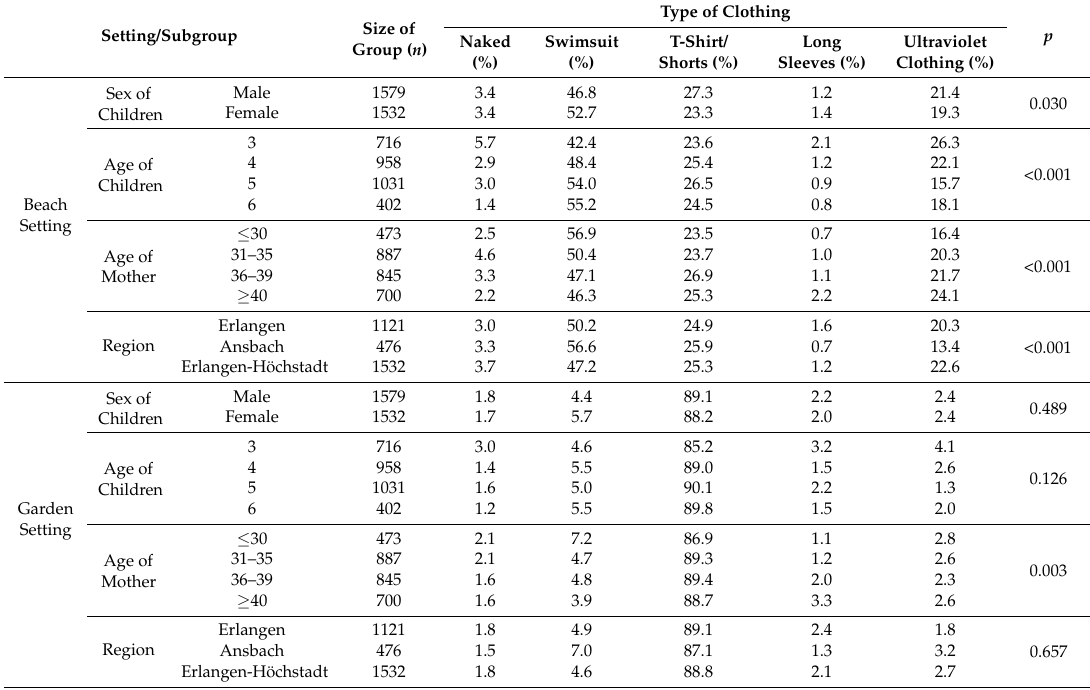
Table 1. Types of clothes worn in two outdoor settings (beach—upper part and garden—lower part) based on answers of 3129 parents of three- to six-year old children in the Erlking-II-study in three Bavarian districts in Southern Germany. Type of Clothing Setting/Subgroup Size of Ultraviolet Group ( n ) Clothing (%) Sex of Children